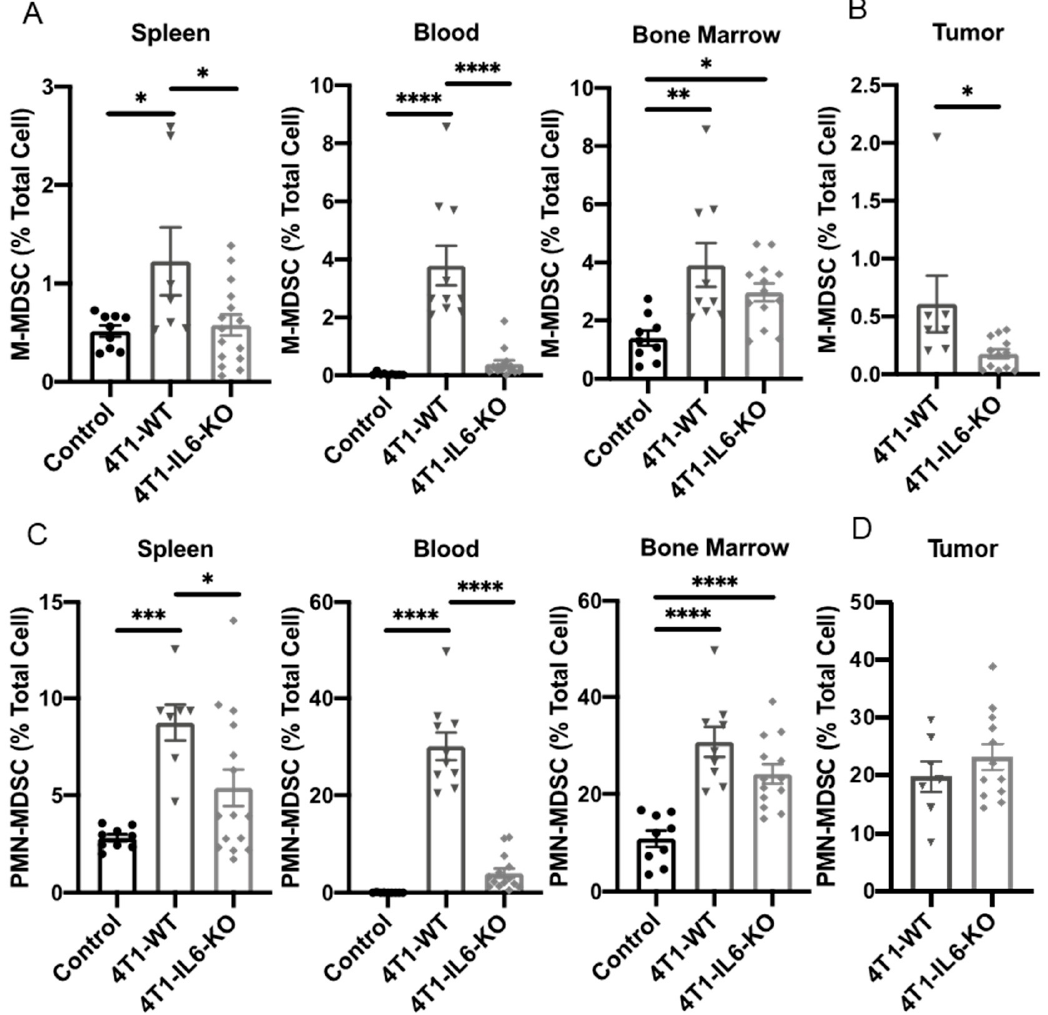
Figure 12. Knocking out tumor cell IL-6 production significantly reduces M-MDSC and PMN- MDSC recruitment. Tumors and peripheral tissues harvested 28 d after engraftment of 4T1-WT and 4T1-IL6-KO cell lines were analyzed for proportions of ( A , B ) M-MDSC and ( C , D ) PMN-MDSC. Healthy, non-tumor-bearing mice were analyzed for comparison (control); see Figure 2 for gating strategy. Data are presented as mean ± SEM; n = 4–11 mice/group. * p < 0.05, ** p < 0.01, *** p < 0.001, and **** p < 0.0001.